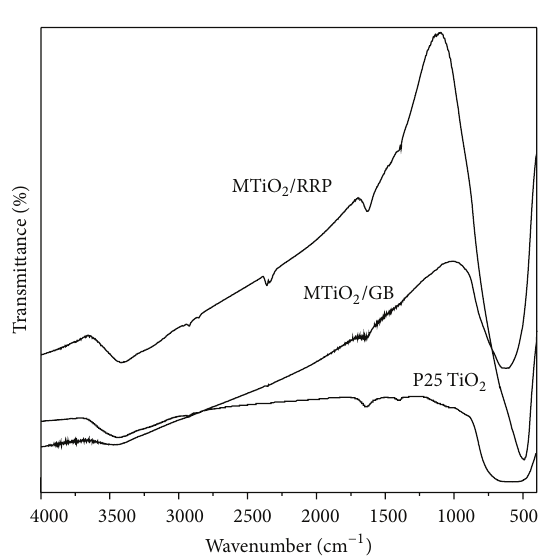
Figure 7: FT-IR spectra of MTiO 2 /RRP, MTiO 2 /GB, and